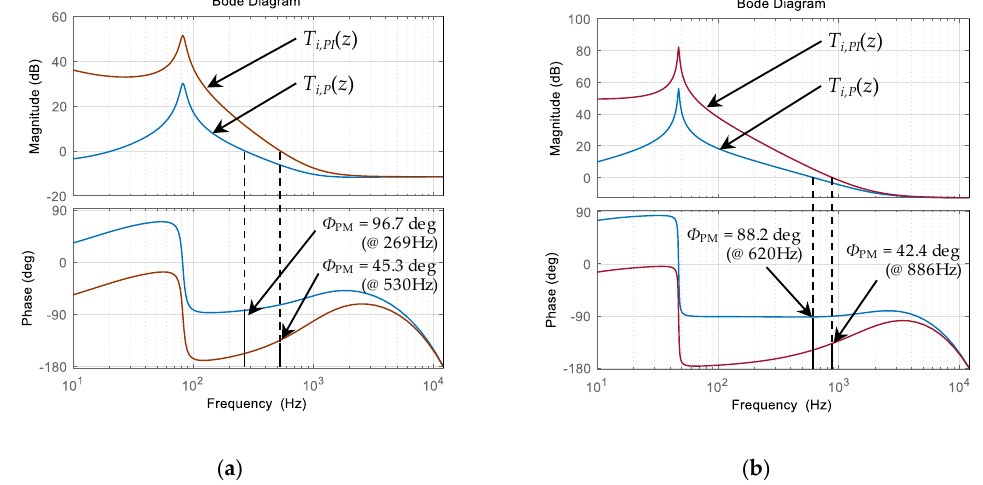
Figure 7. Frequency response of T i ( z ): ( a ) Buck mode; ( b ) Boost mode.